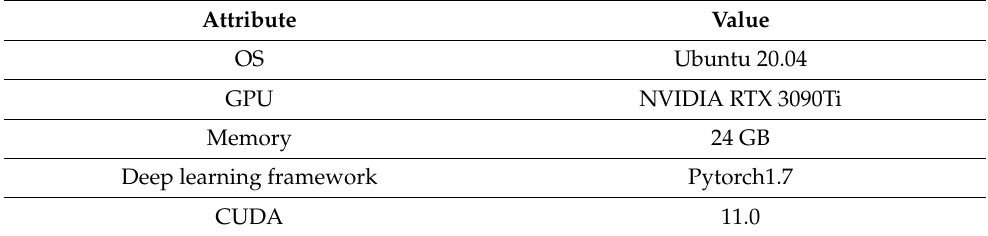
Table 1. Experimental environment configuration.